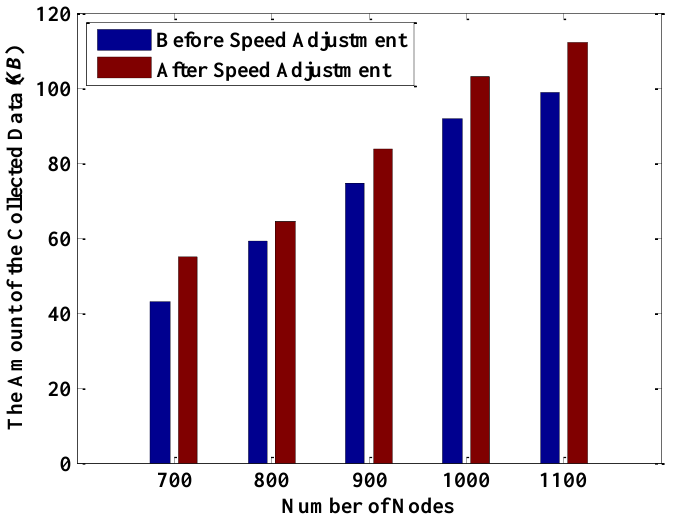
Figure 20. The amount of date collected before and after speed adjustment under different number of nodes.